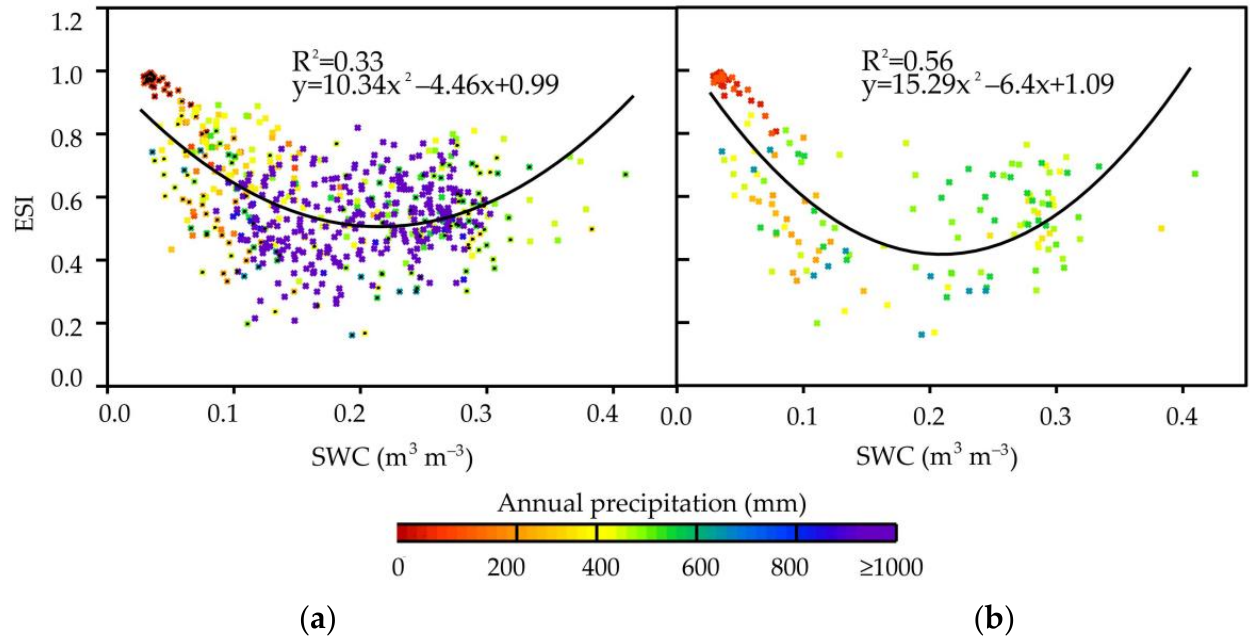
Figure 8. Variation of ESI with SWC. ( a ) is the data of all sites in Table 2 and ( b ) is the data of the alpine zones.